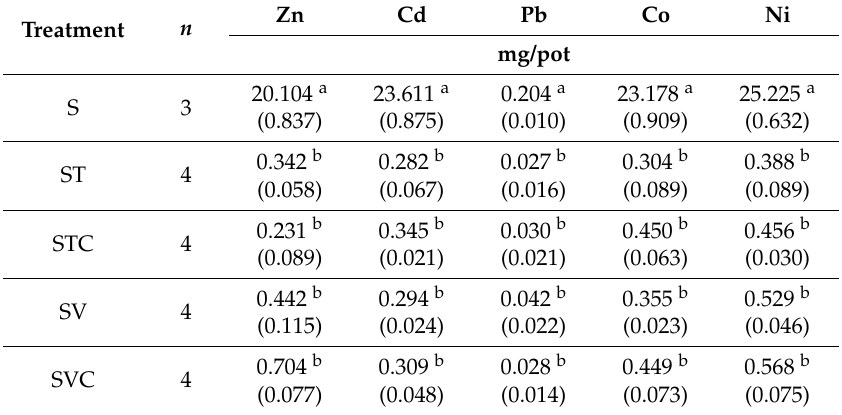
Table 4. Bioavailable metal mass (mg) in soil per pot from control soil (S) and soils amended with thermophilic (T) and vermicompost (V) with and without coir (C) from unvegetated pots. Numbers inside parenthesis indicate ± 1 S.E. ( n = number of